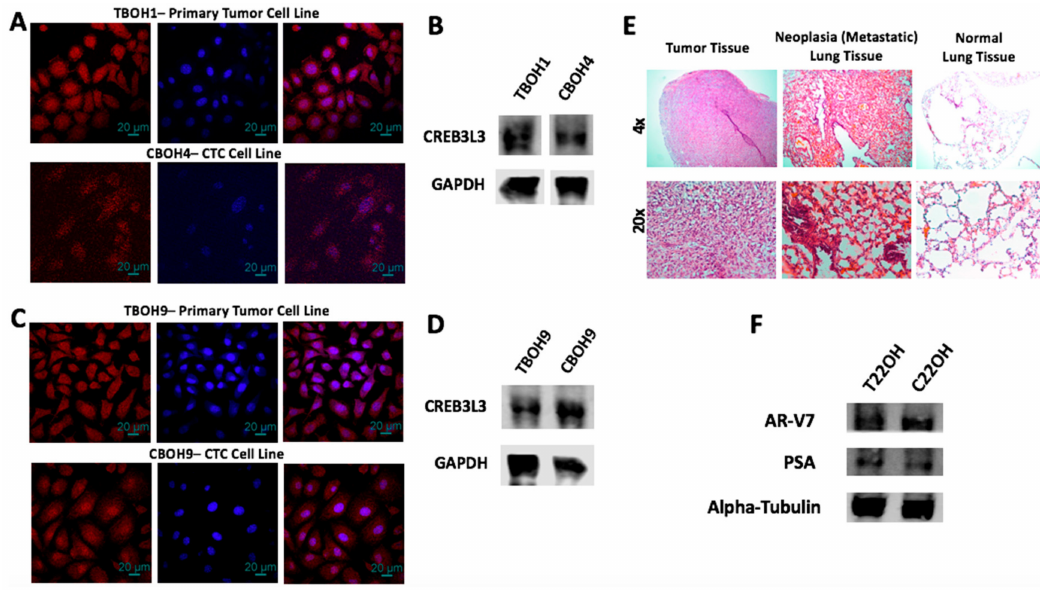
Figure 2. CTCs express tissue-specific markers and were obtained from mice that developed cancer metastasis. ( A , C ) Immunofluorescence staining for CREB3L3, a liver-specific marker; and ( B , D ) western blotting for CREB3L3. DAPI nuclear staining is shown in blue; CREB3L3 cytoplasmic staining is shown in red. ( E ) H&E staining of tumor and lung tissues from implantation of HCC cell line into BALB / c mice demonstrates evidence of cancer metastasis to lungs of cancer-bearing mice. ( F ) Western blotting was carried out to demonstrate prostate cancer origin for both CRPC primary tumor-derived and CTC lines. Experiments were carried out at least three